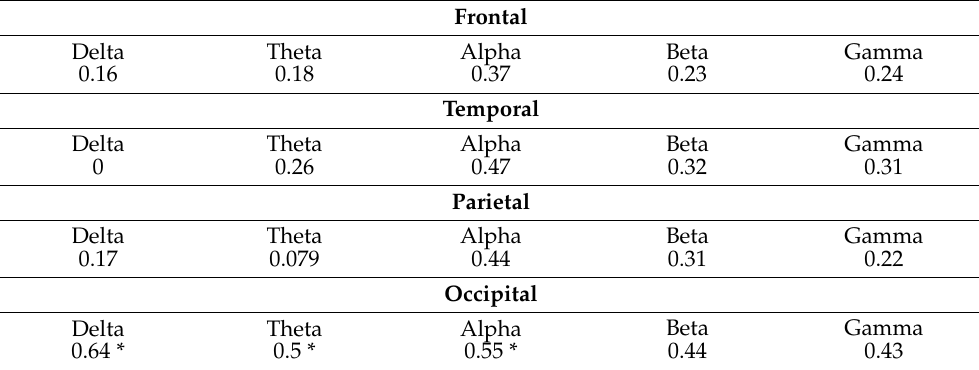
Table 4. Spearman Correlation of the alteration of each power band with the alteration of BPM. The symbol * indicates high correlation ( ≥ 0.5).